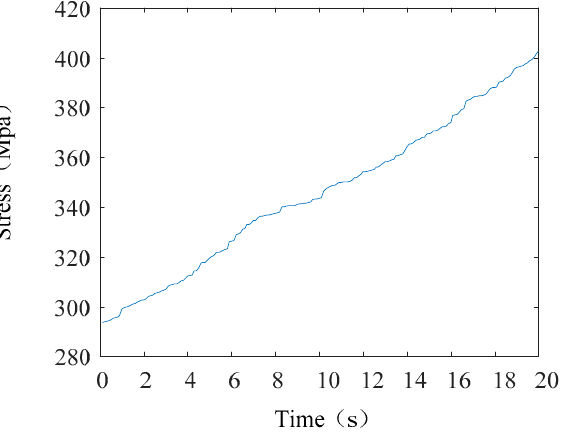
Figure 19. Maximum stress curve.